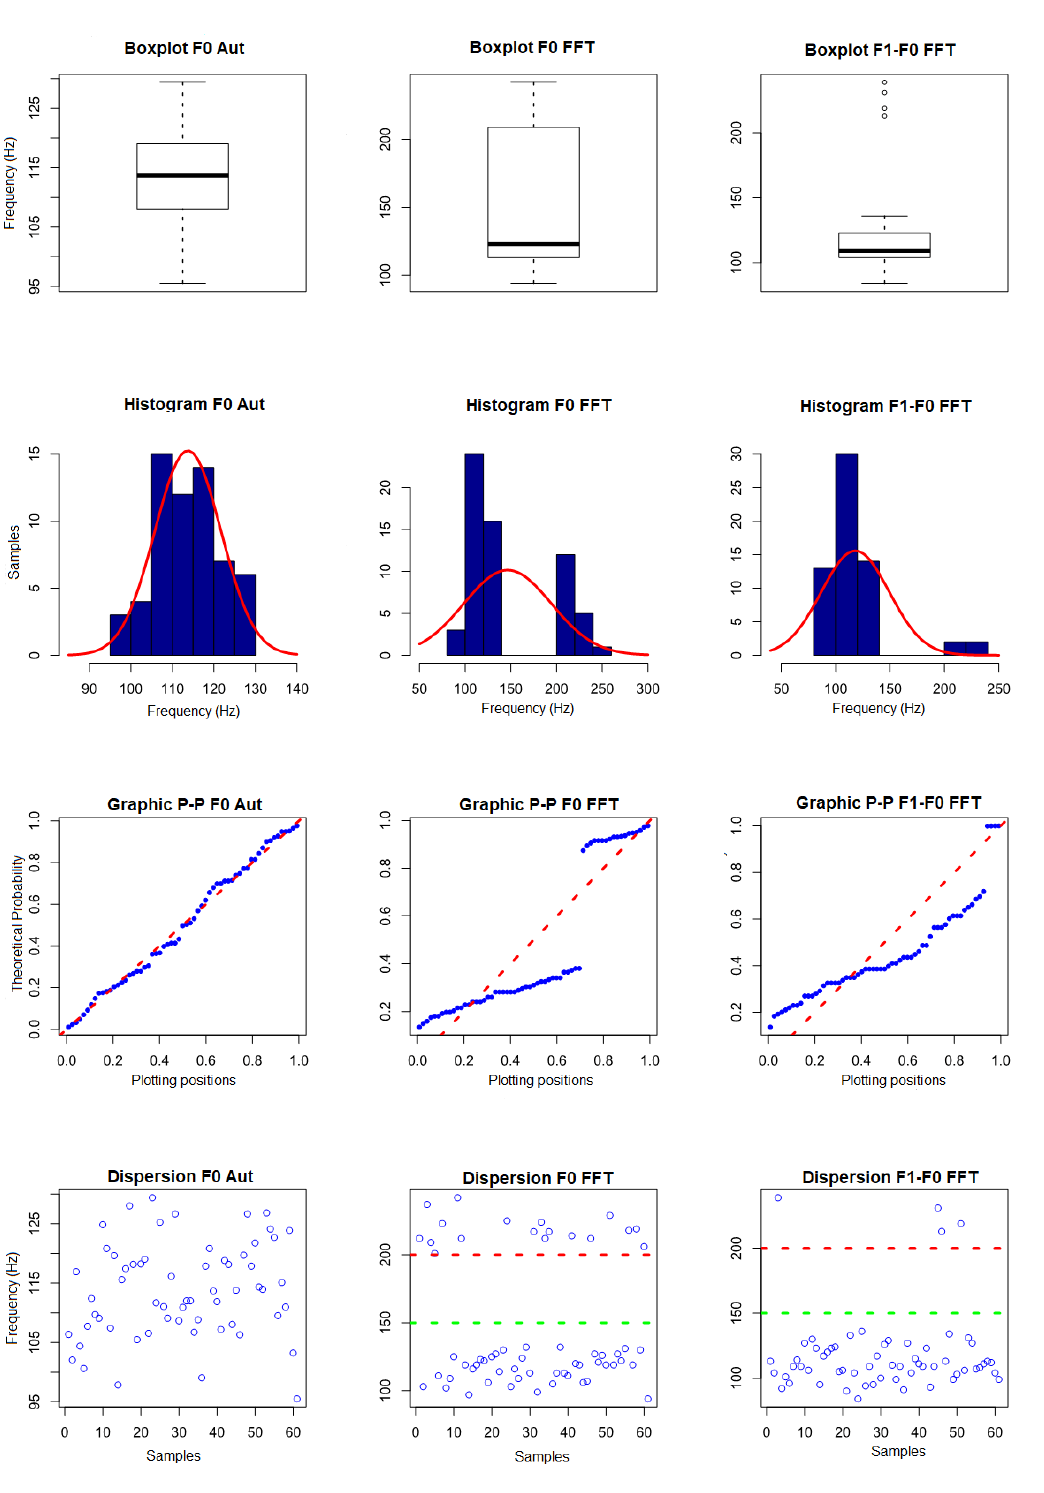
Figure 19. Graphics of the visual evaluation of the data obtained with the events of passage of A. fraterculus of the standard group without removal of